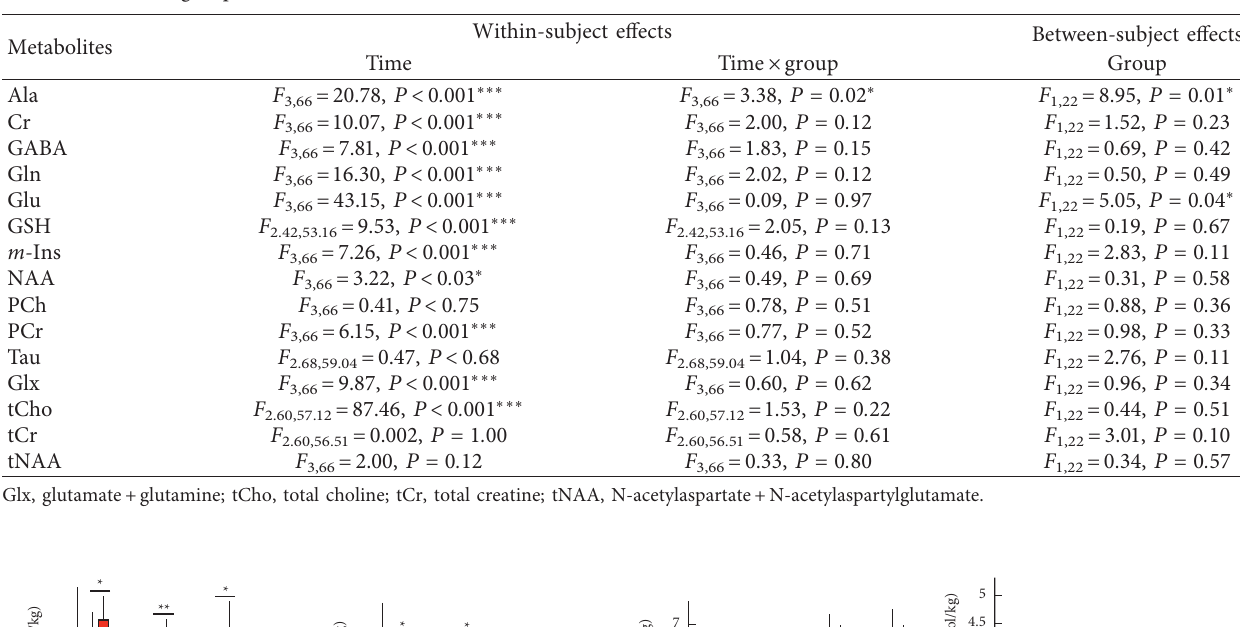
Table 1: The effects of acute restraint stress through two-way repeated-measures ANOVA at four time points. Each metabolite was analyzed whether there were effects over time and interaction between time and groups with within-subject effects and whether there was a significant difference between groups due to acute stress.